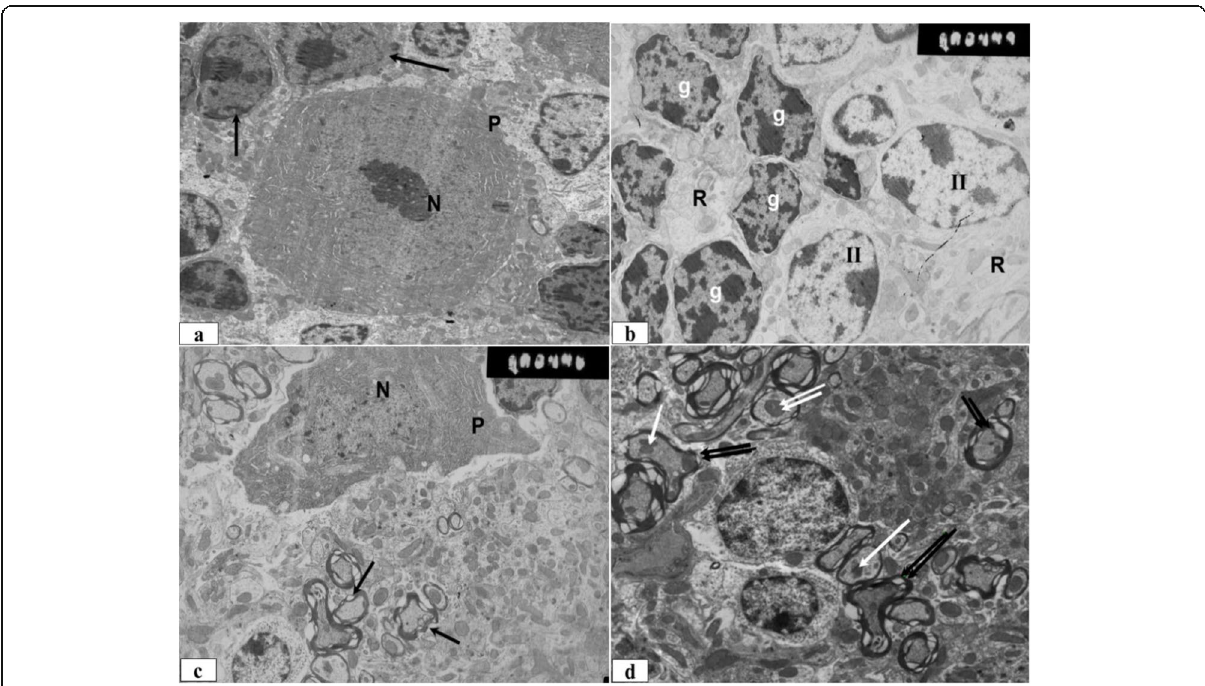
Fig. 4 a – d Electron micrographs of a section of the cerebellar cortex of the cerebellum. a , b In control mice showing the nucleus (N) of Purkinje cell (P), the nuclei of the granular (g) layer, and Golgi II cells. c , d In mice intraperitoneally injected with 5 mg/kg bw cisplatin showing the nucleus (N) of a shrunken Purkinje cell (P). Notice the splitting of the myelin sheath in some areas of myelinated fibers (arrows) in the molecular layer. × 5000 (bar = 10 μ